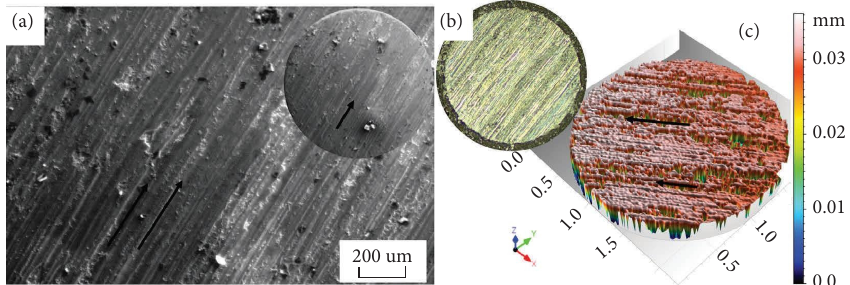
Figure 14: SEM image, optical microscopy, and 3D surface topographies of the wear track of the Cu ball.